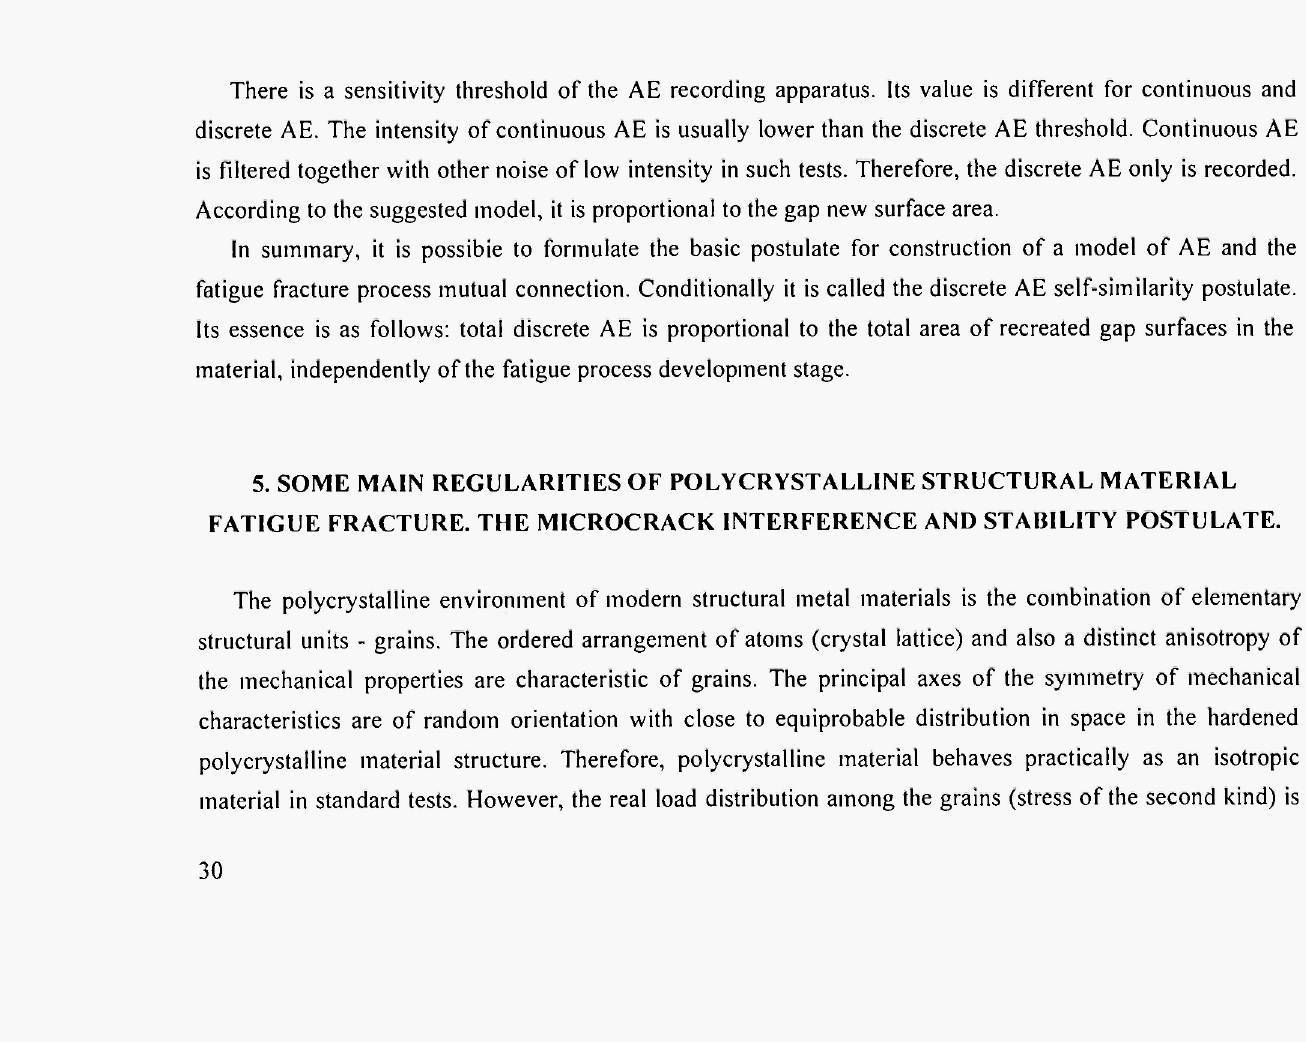
Fig. 7: Material elementary volume strain diagram at half-cycle of the load